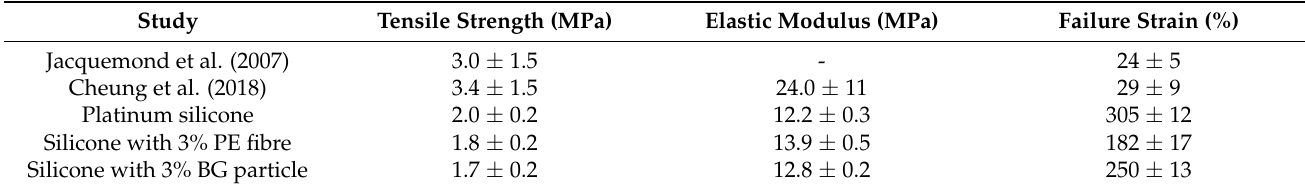
Table 2. Comparison between the tensile properties of the proposed composites and the human scalp in the